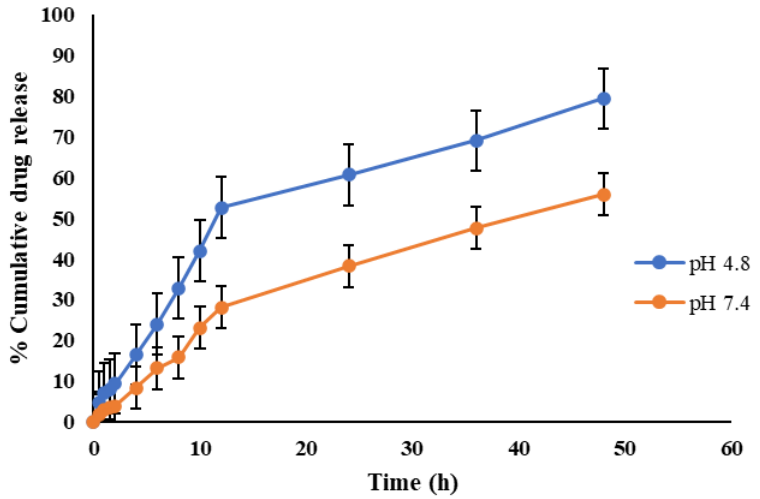
Figure 6. In vitro drug release profile of meloxicam from chitosan-encapsulated meloxicam nanoparticles (CEMNPs) at pH 4.8 and 7.4.